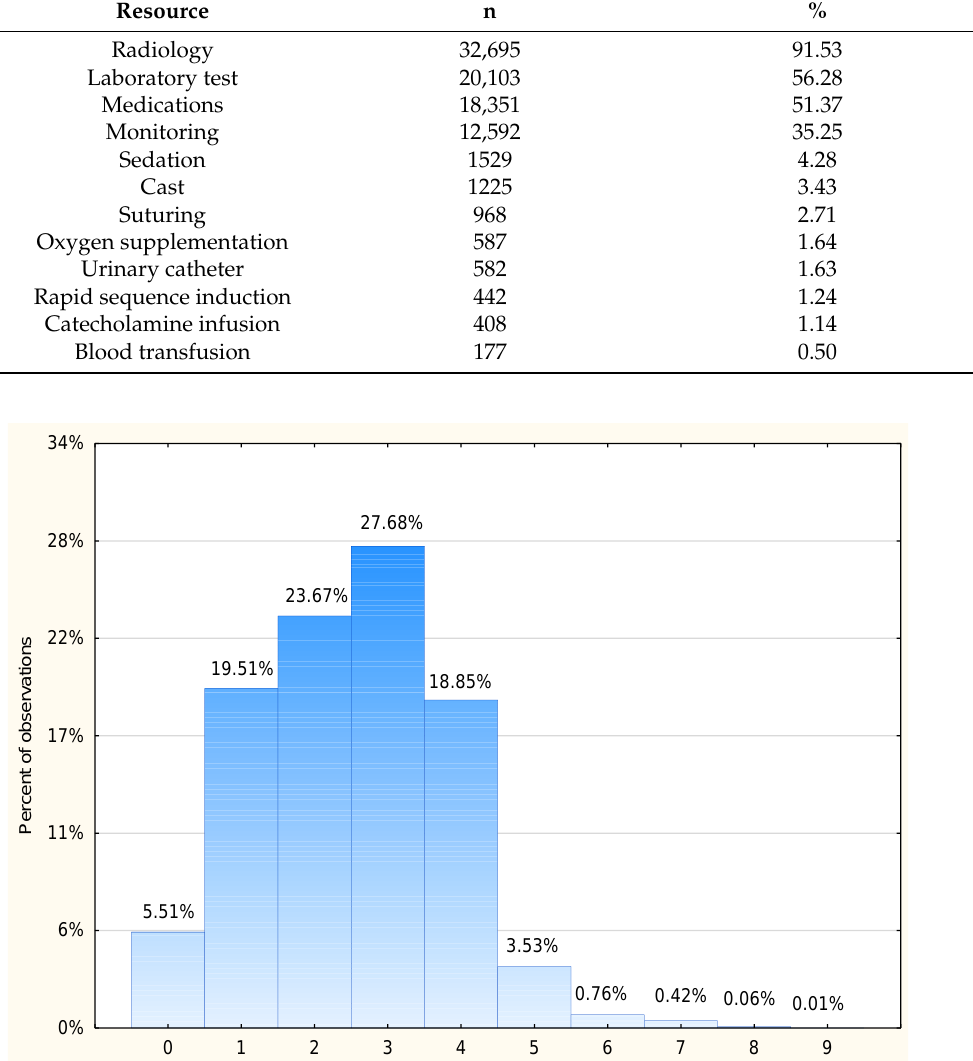
Table 2. The detailed number of resources used for geriatric patients.